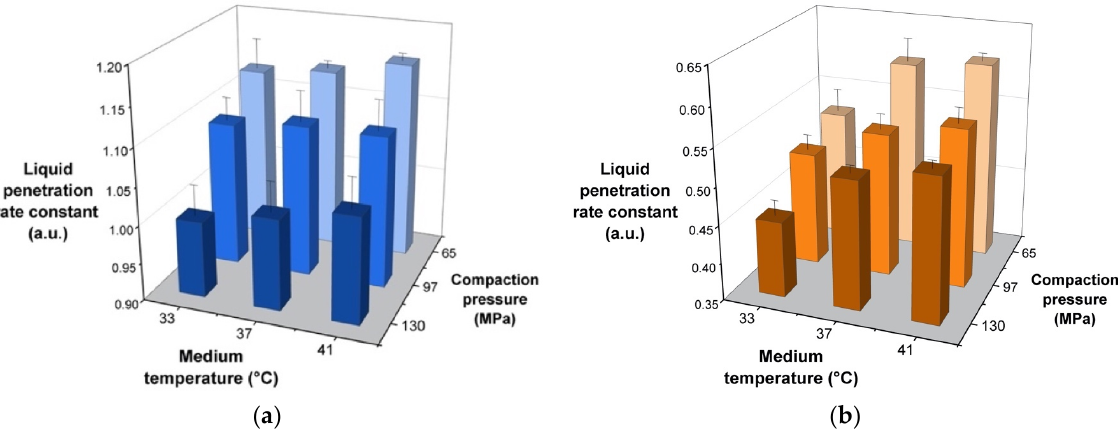
Figure 3. Plots of liquid penetration rate constant of tablets containing ( a ) SSG and ( b ) XPVP produced at different compaction pressures. Table 1. Tensile strength and porosity of tablets produced. Disintegrant Compaction Pressure (MPa)